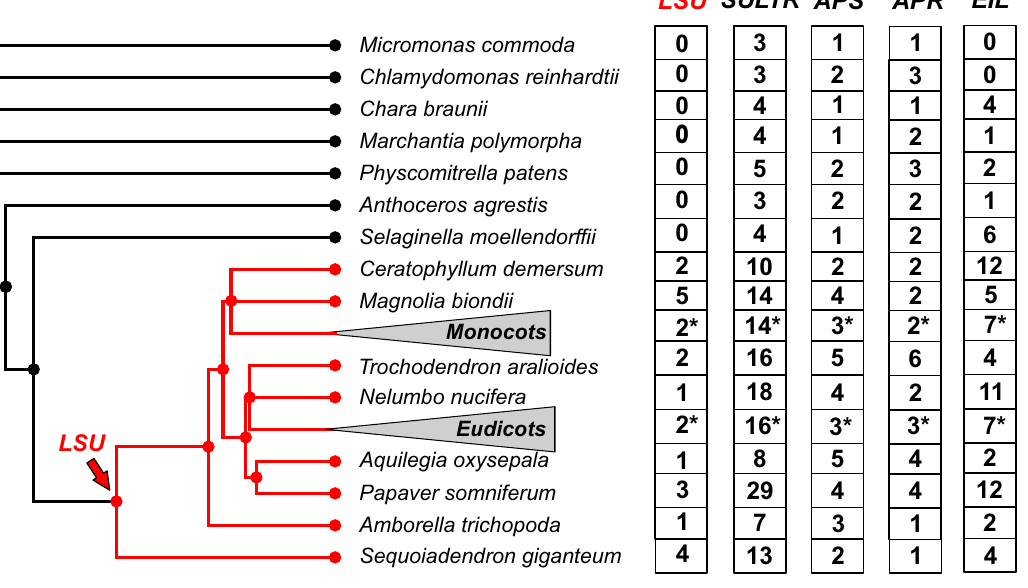
Figure 1. The LSU gene family appeared recently in plant evolution compared to other S- responsive genes. The phylogenetic tree was constructed according to [17]. To improve visual- ization, 73 eudicotyledon and 31 monocotyledon species collapsed in the phylogenetic tree (trian- gle), and the average number of LSU genes are indicated with an asterisk. The copy number of LSUs , sulfate transporters ( SULTR ), ATP sulfurylases ( APS ), adenosine 5’-phosphosulfate reductase (APR), and ethylene-insensitive3-like transcription factors ( EIL ) was obtained from the PLAZA 5.0 database [18]. The number of LSU genes varies between angiosperm plants, ranging from 1 to 9 mem- bers [17]. This variation is mainly due to genome size, as a significant positive